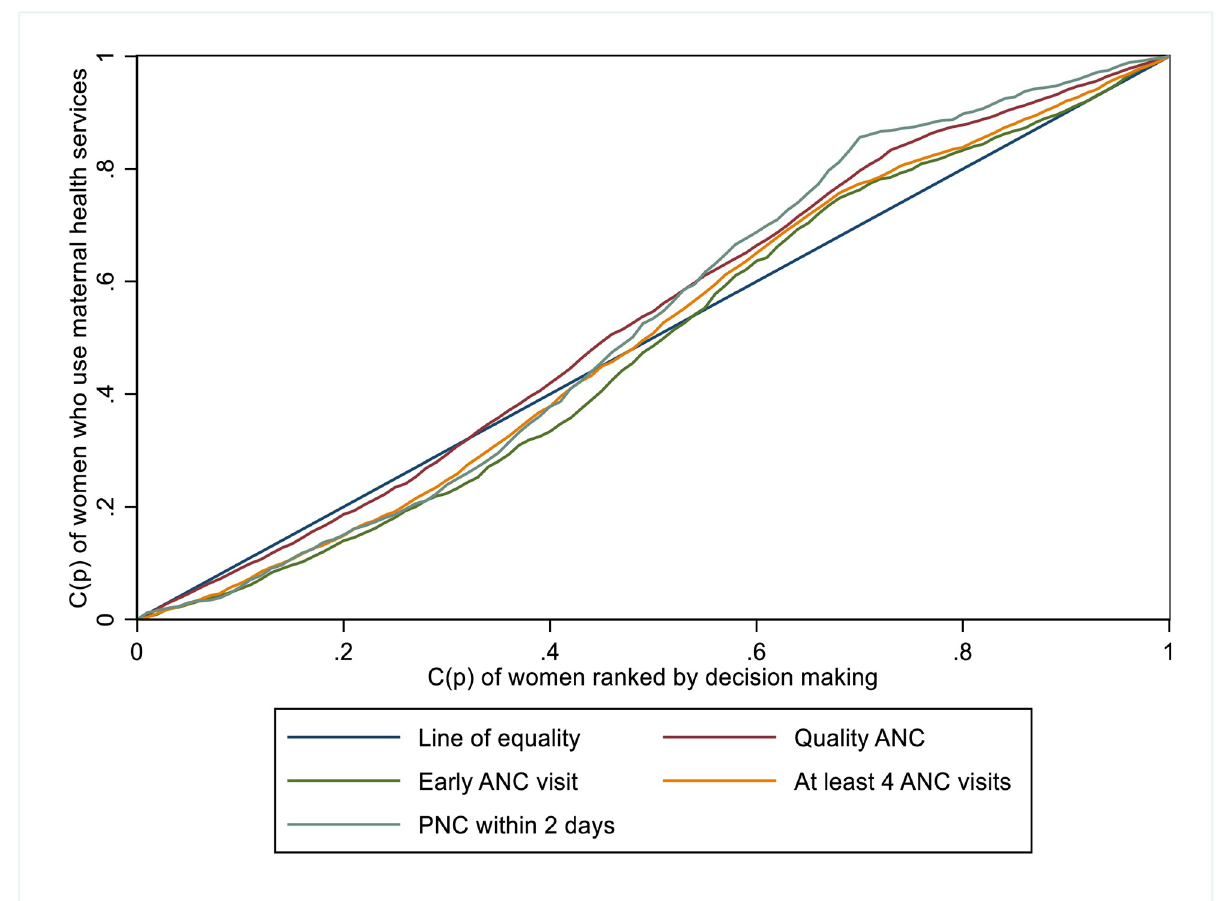
Fig 3. Concentration curves of maternal health services based on decision making domian of women’s empowerment. Note: C(p) refers to cumulative proportion.